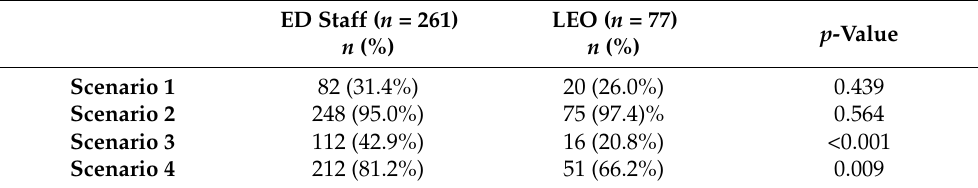
Number (percentage) of respondents indicating the scenario demonstrated a reportable